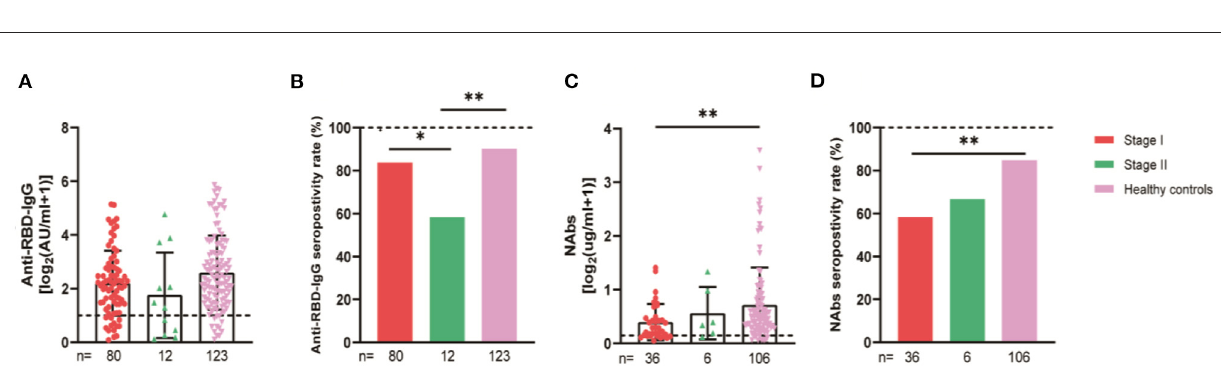
55.9 vs. 84.9%, p < 0.001), but they were not significantly different for the PT group and the healthy population (Figure 11). However, the antibody titers and seroconversion rates of the thyroid cancer patients who completed treatment were not significantly different from those of the healthy population (Figures 11A, B). Finally, the participants